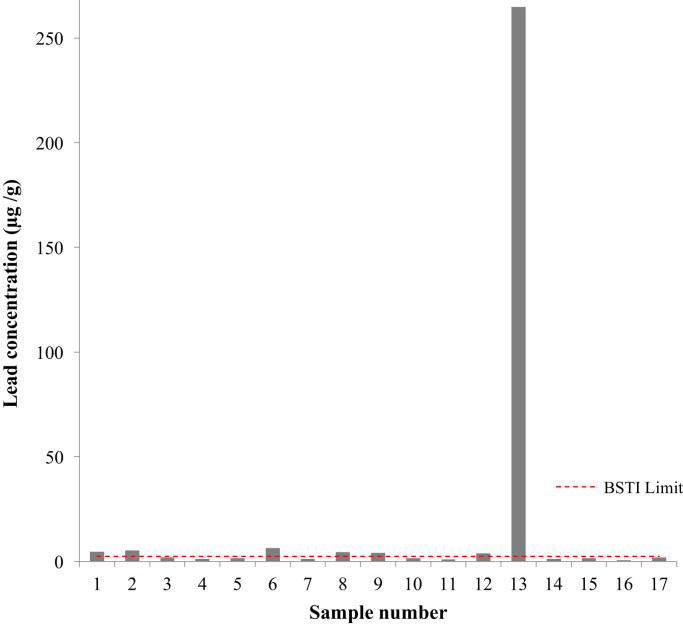
Lead concentration in 17 samples of turmeric from 20 randomly selected households. Seven of the 17 samples had a lead concentration greater than the Bangladesh Standards and Testing Institution's (BSTI) limit of 2.5 μg/g in turmeric.